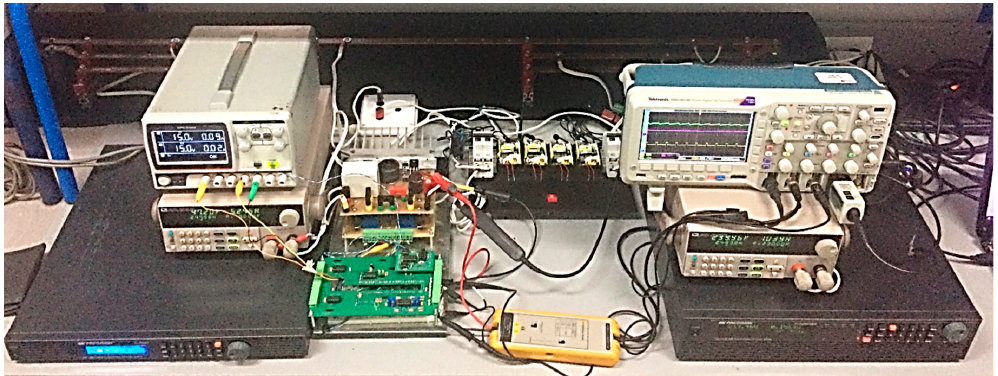
Figure 15. Prototype and experimental setup used for obtaining experimental results.